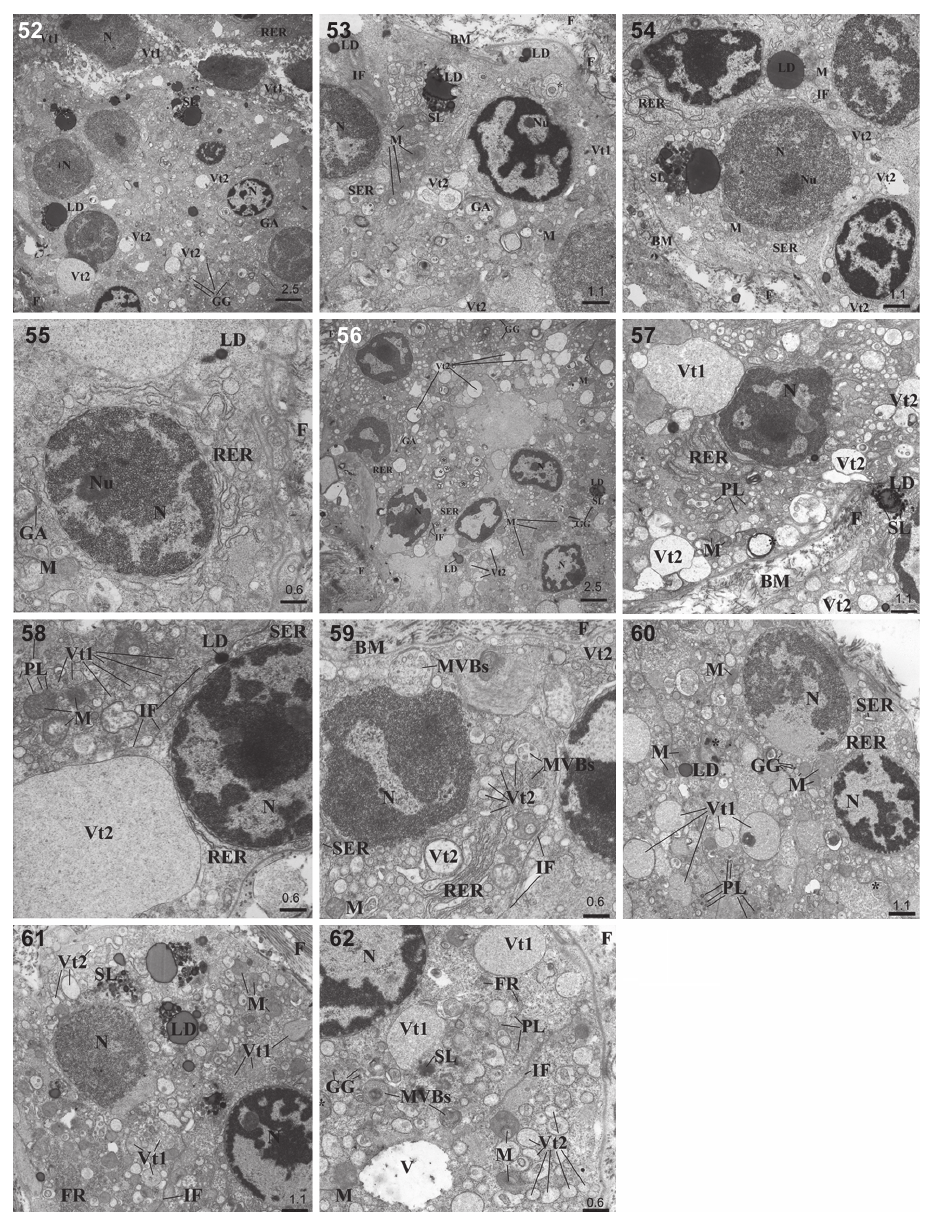
Figures 52-62. Survey electron micrograph of the HG, LG and SGTE cells in European bison. (52-55) HG cells: (52) Note of the secretory cells. Bar = 2.5 µm; (53) Note secretory cells with vesicles type 1 and 2. Bar = 1.1 µm; (54) Note secretory cells with vesicles type 1 and 2 and big lipid drops. Bar = 1.1 µm; (55) Visible part of plasma cell. Bar = 0.6 µm; (56-59) LG cells: (56) Note of the secretory cells. Bar = 2.5 µm; (57) Note secretory cells with vesicles type 1 and 2. Bar = 1.1 µm; (58) Note secretory cells with vesicles type 1 and 2. Bar = 0.6 µm; (59) Clearly visible multivesicular bodies (MVBs). Bar = 0.6 µm; (60-62) SGTE cells: (60) Note of the secretory cells with vesicles type 1 and 2. Bar = 1.1 µm; (61) Note secretory cells with lipid drops and secondary lysosomes. Bar = 1.1 µm; (62) Note secretory cells with vesicles type 1 and 2 and multivesicular bodies (MVBs). Bar = 0.6 µm. (N) Nucleus of the cell, (Nu) nucleolus, (RER) rough endoplasmic reticulum, (M) mitochondria, (SER) smooth endoplasmic reticulum, (GG) glycogen granules, (LD) lipid drops, (SL) secondary lysosomes, (BM) basement membrane, (F) filaments, (GA) Golgi apparatus, (IF) intermediate filaments, , (PL) primary lysosomes, (MVBs) multivesicular bodies, (Vt1) vesicles type 1, (Vt2) vesicle type 2, (FR) free ribosomes, (V) vacuola, (*) extensive membrane structures arranged in concentric